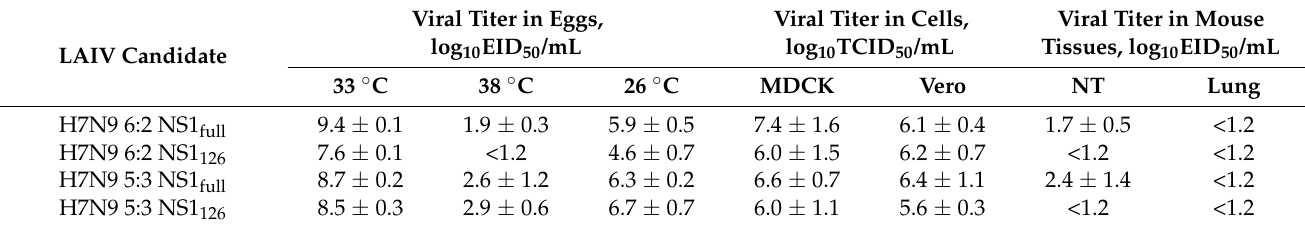
Viral Titer in Cells, Viral Titer in Mouse log 10 TCID 50 /mL Tissues, log 10 EID 50